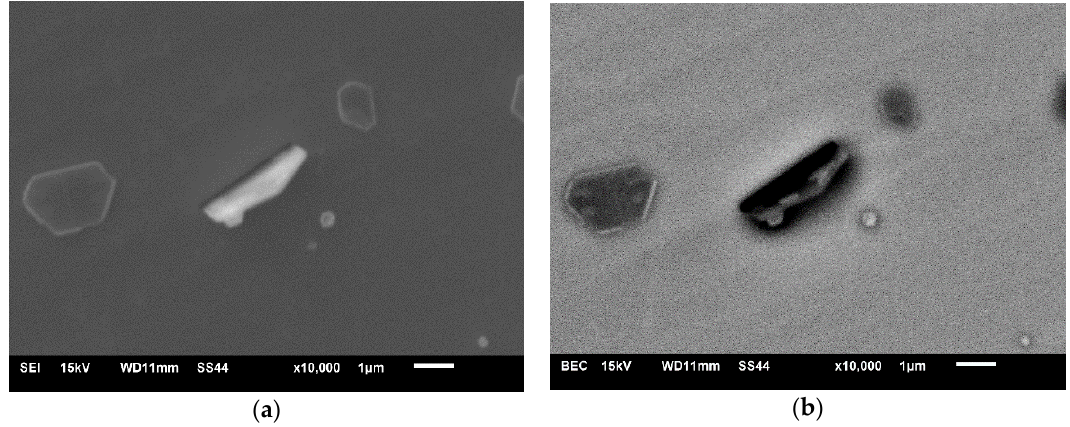
Figure 10. ( a ) Secondary electron images (SEI) and ( b ) back-scattered electron (BSE) images of AlN inclusions which are positioned in a different angle.